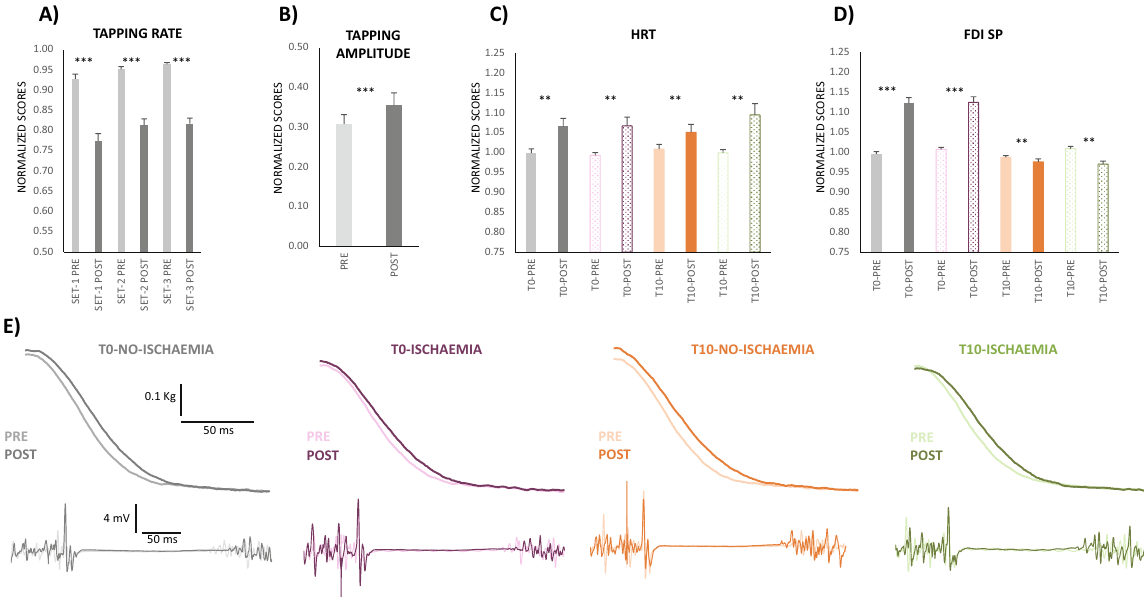
Figure 2. Expression of fatigue in the absence of M1 neuromodulation (shamTBS session). ( A ) FT rate and ( B ) FT ROM amplitude variables are shown by pooling delays and ischaemia since these factors had no significant effects. The maximal FT rate decreased significantly in 30 s (PRE vs. POST) for all sets and conditions (both delay and ischaemia); with set progression, the maximal rate increased both at PRE and POST (p < 0.001, asterisk omitted). The FT ROM amplitude at POST was larger than PRE for all sets and conditions. ( C ) HRT and ( D ) FDI SP are split by delays and ischaemia conditions for visual comparison (solid bars = no ischaemia; textured bars = ischaemia); HRT showed similar changes for all of them. The HRT ( C ) increased significantly from PRE to POST, and this increase was not different across the delays (T0 and T10), ischaemia levels and set progression. The FDI SP ( D ) increase from PRE to POST was significant only for T0. For T10, SP was significantly reduced at POST. The effects of FT on SP were not different for the two ischaemia conditions. ( E ) Representative recordings of FDI SP and relaxation phase of the resting twitch from the same individual in different ischaemia and delay conditions. **p ≤ 0.01, ***p ≤ 0.001. The y-axis unit score values are shown in Table